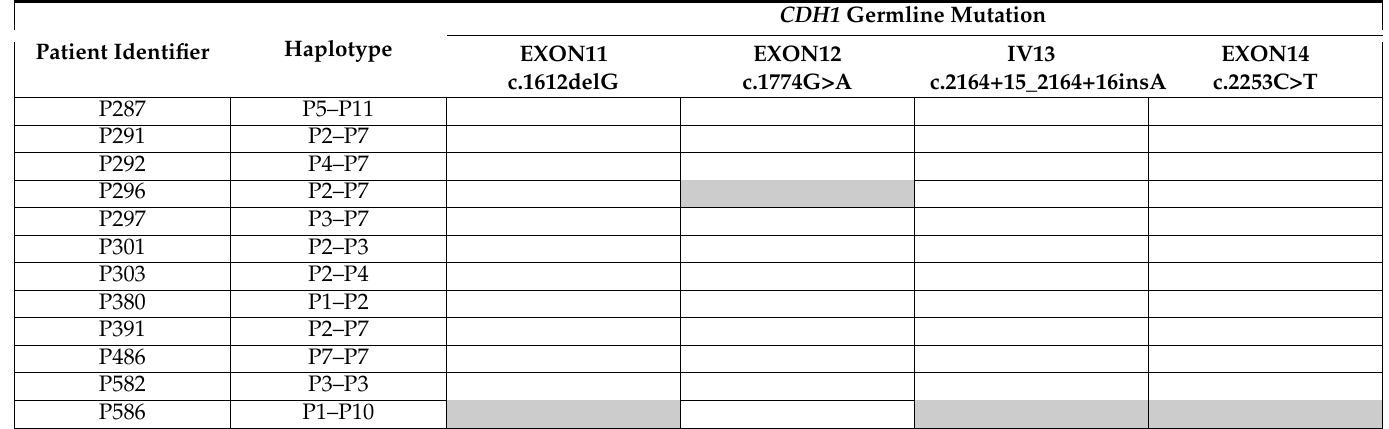
Table 4. CDH1 haplotype plus germline mutation found in patients with HER2